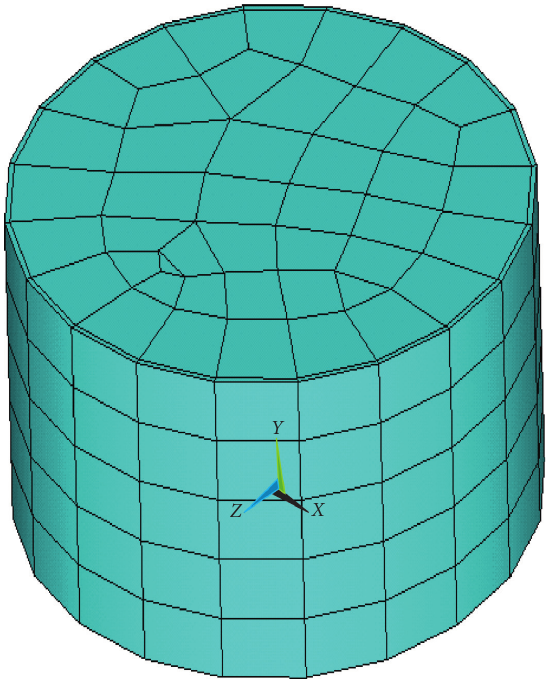
Figure 20: Finite element model mesh